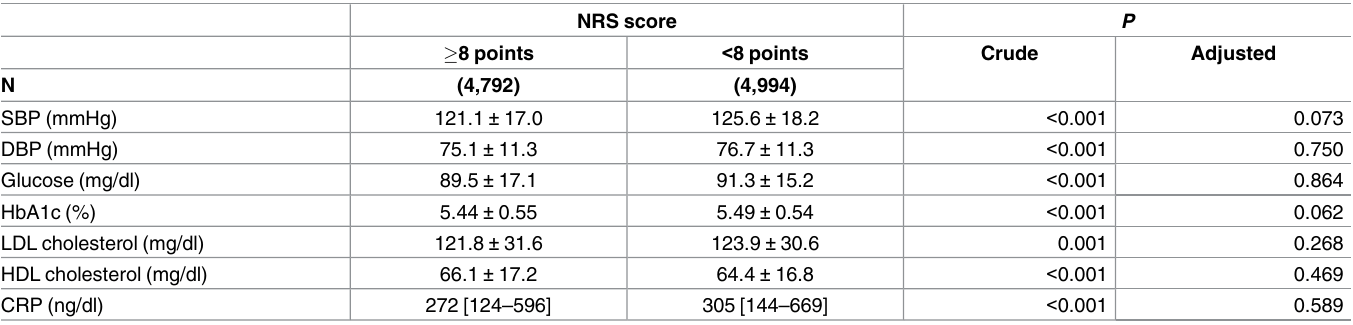
S1 Table. Multivariate logistic regression analysis for subjective NRS. Abbreviations: NRS, non-restorative sleep; BMI, body mass index; GERD, gastroesophageal reflux disease; OR,